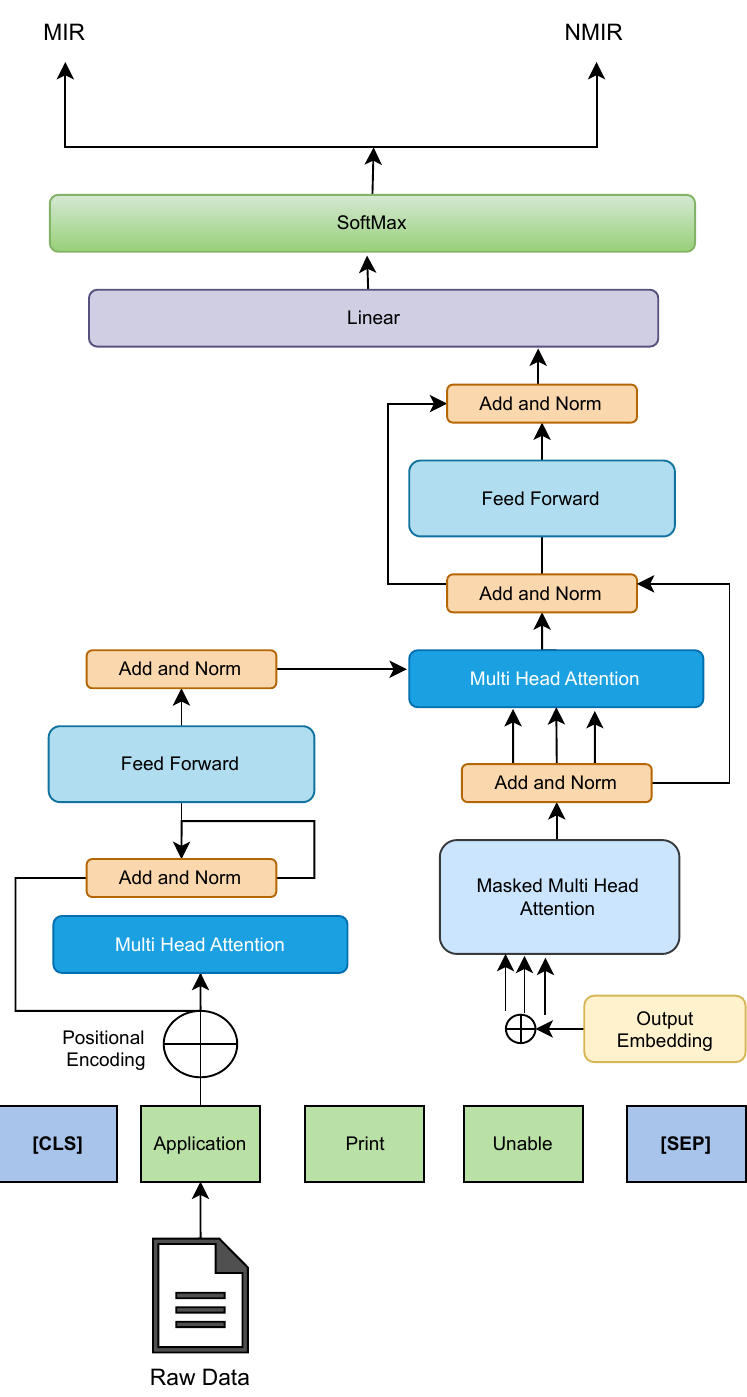
Figure 5. Graphical representation of our best-performing transformer (Roberta) model